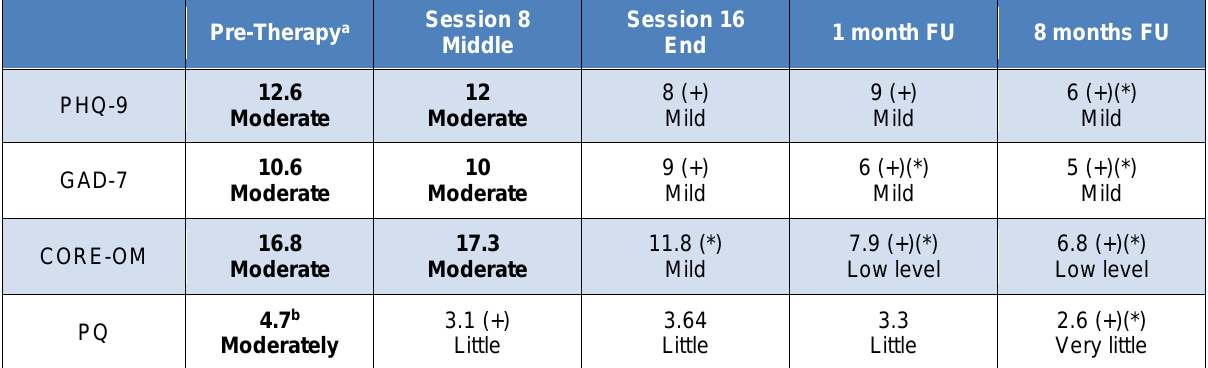
Table 1: Giovanni’s Quantitative Outcome